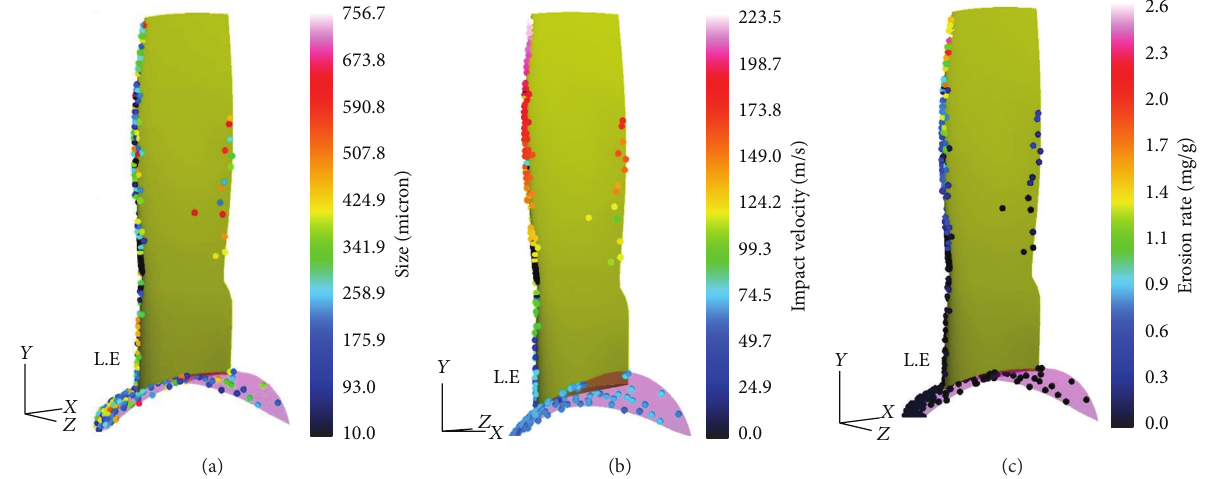
Figure 11: Sample of local impacts on pressure side: (a) particles sizes ( 𝜇 m), (b) impact velocities (m/s), and (c) erosion rates